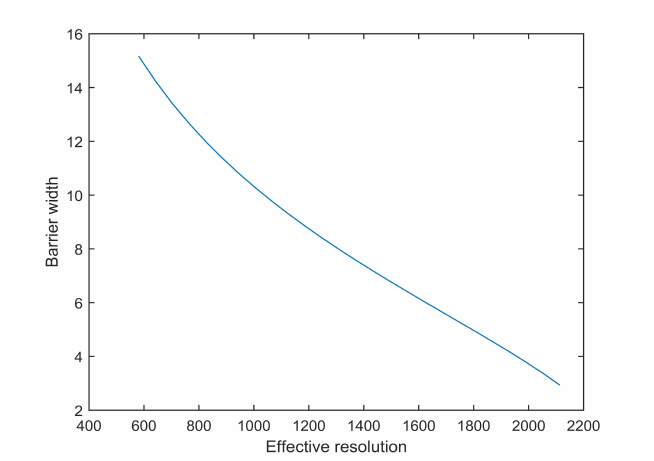
Figure 6. Barrier width vs. required